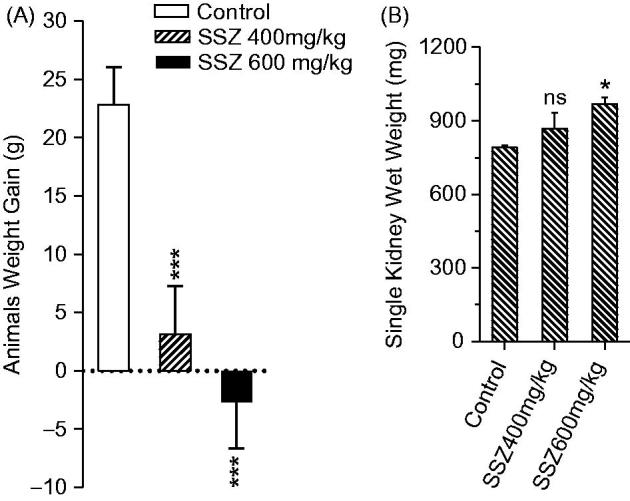
Animals weight gain (A) and kidney weight (B) were assessed after 14 d of sulfasalazine administration. SSZ: sulfasalazine. Data are given as mean ± SD (n = 8). Asterisks indicate significantly different as compared with control animals (*p < .05 and ***p < .001). Superscript “ns” indicates not significant as compared to control group (p > .05).